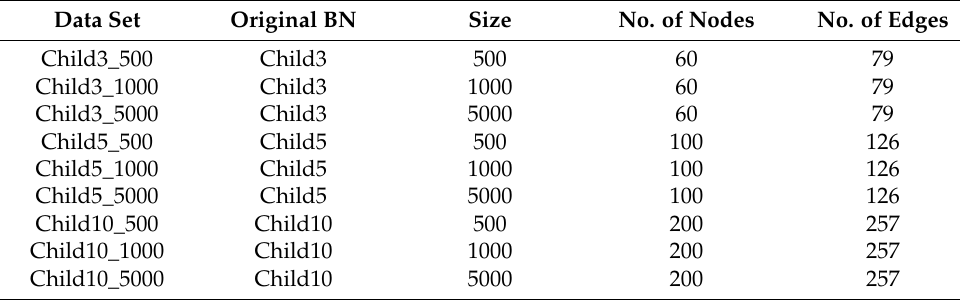
Table 1. General information about benchmark BNs and data